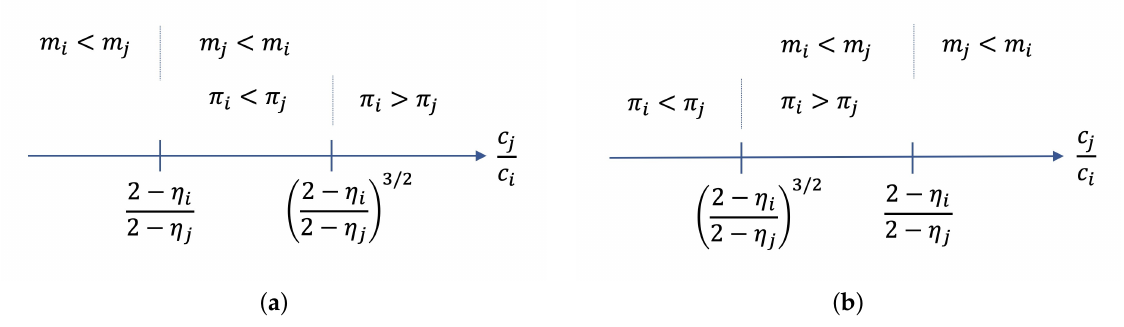
Figure 1. Asset stocks and profits for linear costs. ( a ) Case 2 − η i > 2 − η j , ( b ) Case 2 − η i < 2 − η j